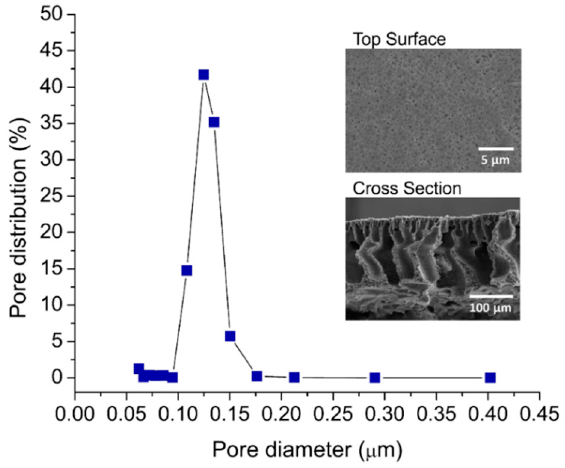
Figure 3. The pore diameter distribution of the developed PVDF membrane. The insets show their morphological images.